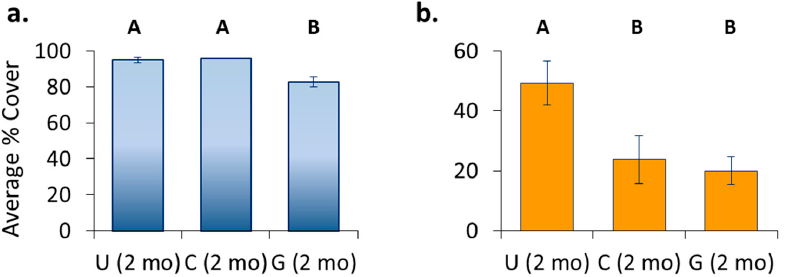
Figure 11. Differences in fouling due to prior husbandry, uncleaned dominance. ( a ) Cover of macrofouling on 3140 at Port Canaveral in September was significantly higher on uncleaned and cleaned panels than on groomed ones on panels that came from the Port ( p < 0.001). ( b ) Cover of encrusting bryozoans on 3140 at Sebastian in September was significantly higher on uncleaned than on cleaned or groomed panels ( p = 0.011). The X-axes are treatments; the Y-axes are average percent cover. Please note that Y-axes vary. Treatments are uncleaned (U), cleaned (C) and groomed (G). The time in the parenthesis is elapsed time since cleaning and transplant. Letters above the bars denote sta- tistical significance (i.e., As are statistically similar to, but significantly different than, Bs). Figure 12. Differences in fouling due to prior husbandry, cleaned dominance. ( a ) Cover of barnacles on IS900 at Sebastian in August was significantly higher on cleaned panels than uncleaned ones on panels that came from Sebastian ( p < 0.05). ( b ) Cover of barnacles on IS900 at Port Canaveral in August was significantly higher on cleaned than on uncleaned and groomed panels on panels that came from Sebastian ( p < 0.001). ( c ) Cover of sponges on IS700 at Port Canaveral in September was significantly higher on cleaned panels than on uncleaned and groomed ones on panels of Port origin ( p < 0.05). ( d ) Cover of sponges on IS900 at Sebastian in September was significantly higher on cleaned panels than on groomed ones ( p = 0.024). The X-axes are treatments; the Y-axes are average percent cover. Please note that Y-axes vary. Treatments are uncleaned (U), cleaned (C) and groomed (G). The time in the parenthesis is elapsed time since cleaning and transplant. Letters above the bars denote statistical significance (i.e., As are statistically similar to, but significantly different than, Bs).